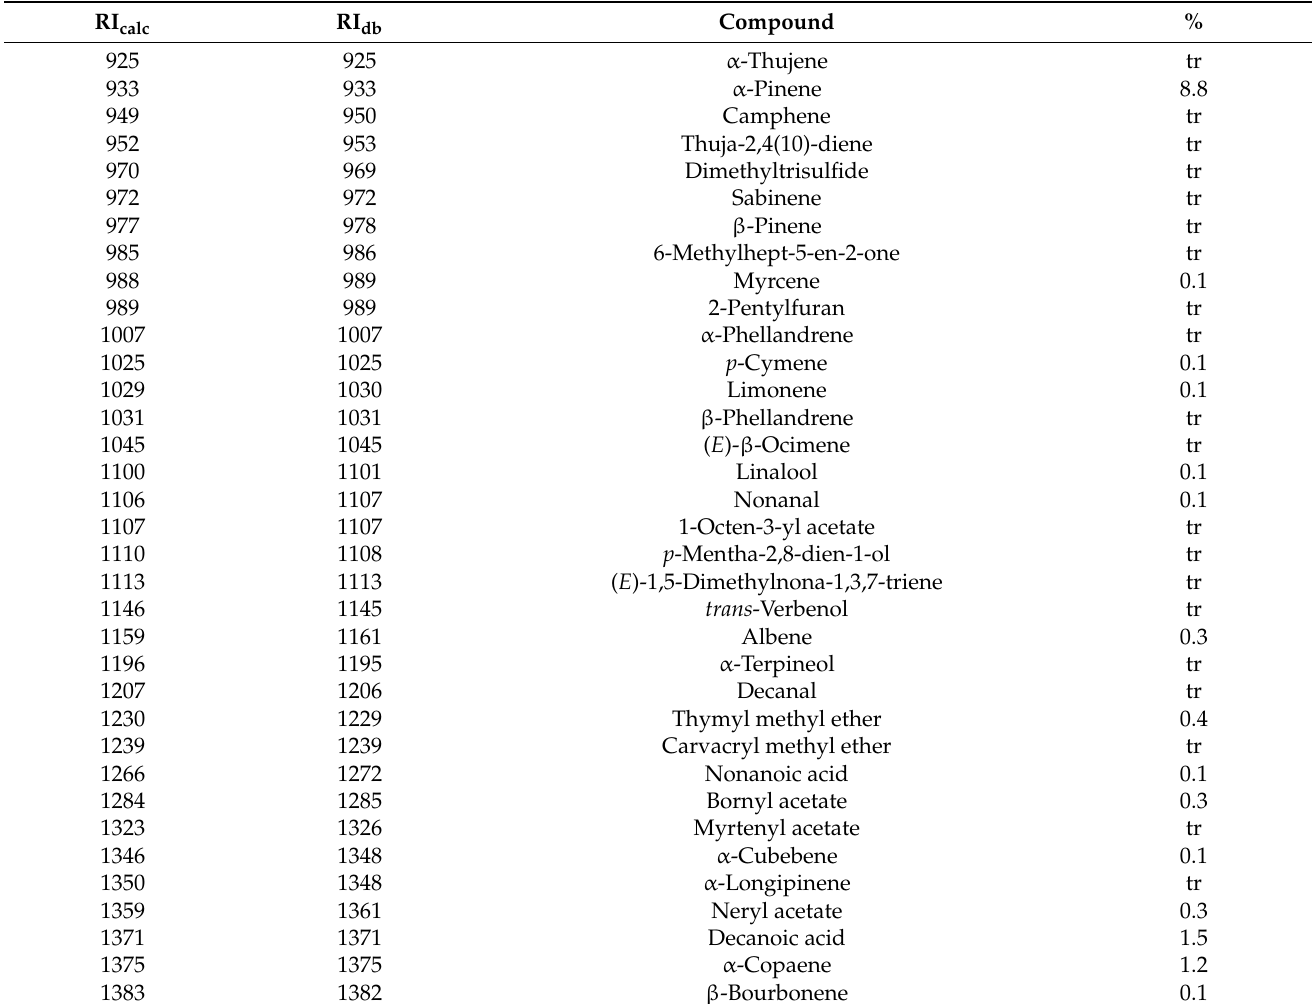
Table 2. Essential oil composition of Blumea sinuata from